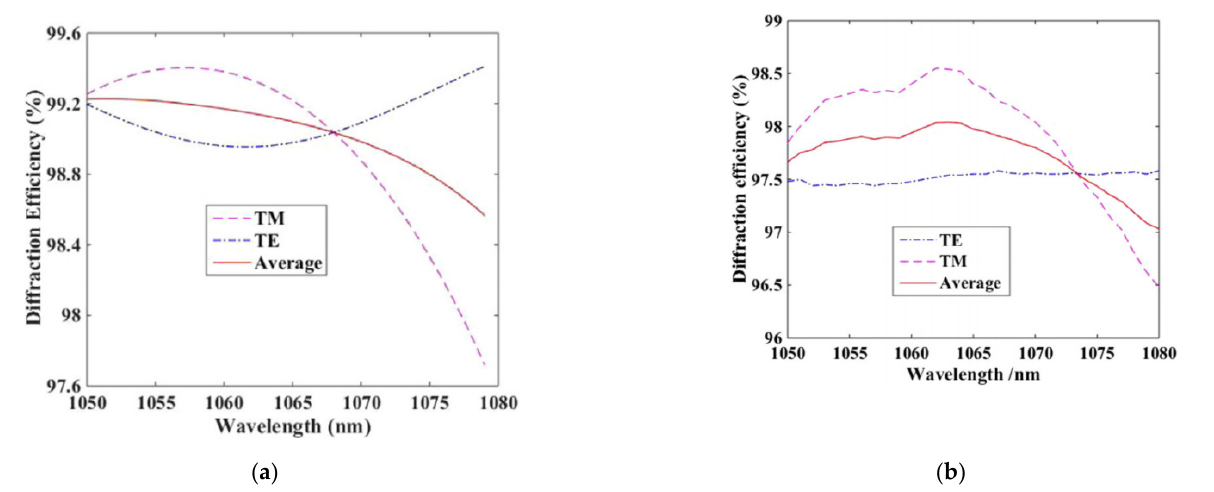
Figure 22. ( a ) Theoretical diffraction efficiency and ( b ) actual diffraction efficiency.